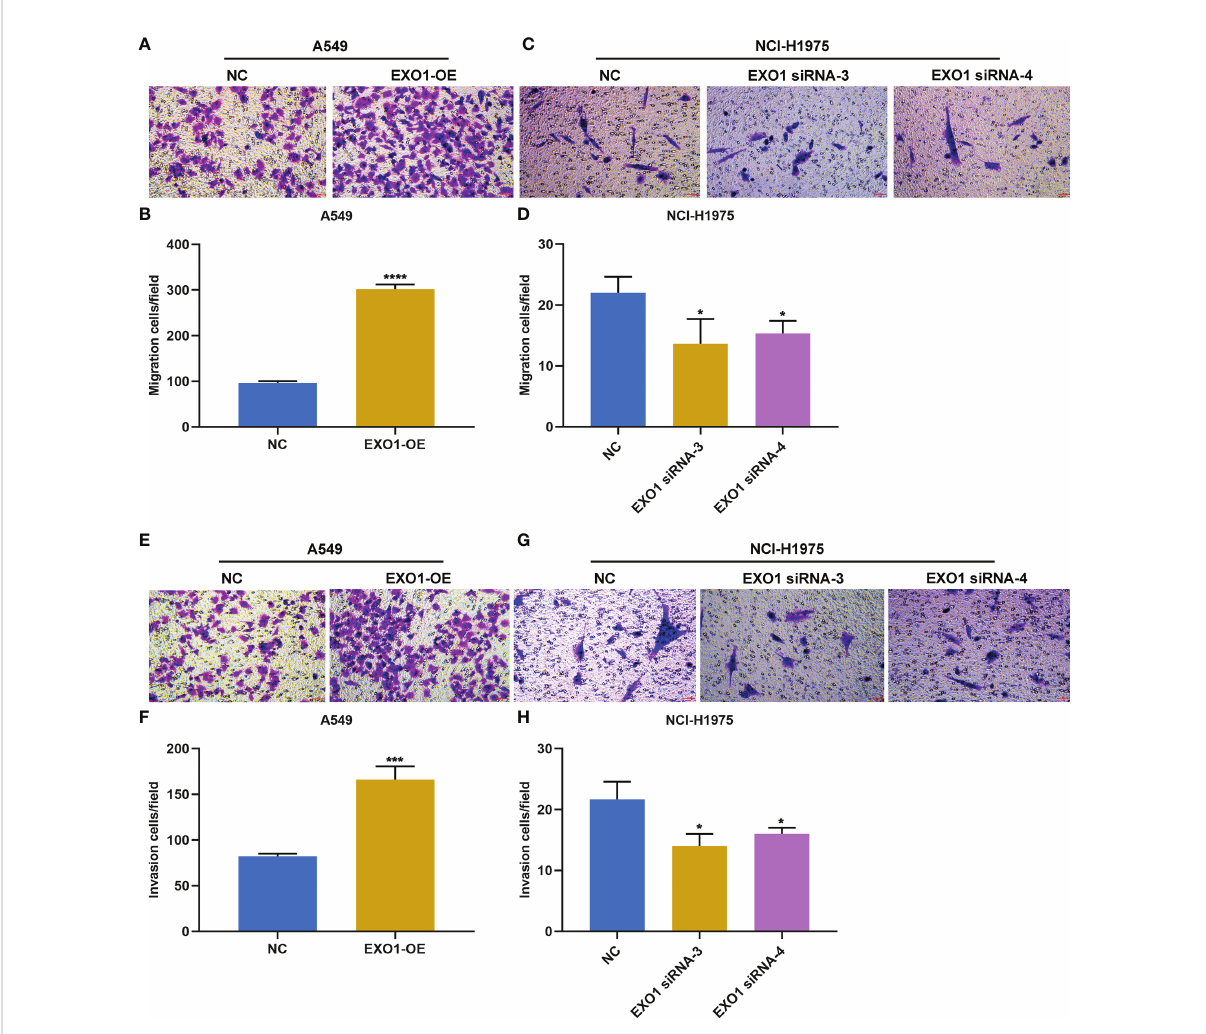
FIGURE 8 EXO1 drives migratory and invasive traits of LUAD cells. (A – D) Representative images of migration assay and number of migratory A549 cells overexpressing EXO1 (EXO1-OE) and NCI-H1975 cells with EXO1 knockdown (EXO1-siRNA). (E – H) Representative images of invasion assay and number of invasive A549 cells with EXO1-OE and NCI-H1975 cells with EXO1-siRNA. Bar, 50 m m. NC, negative control; LUAD, lung adenocarcinoma. *p < 0.05; ***p < 0.001; ****p <